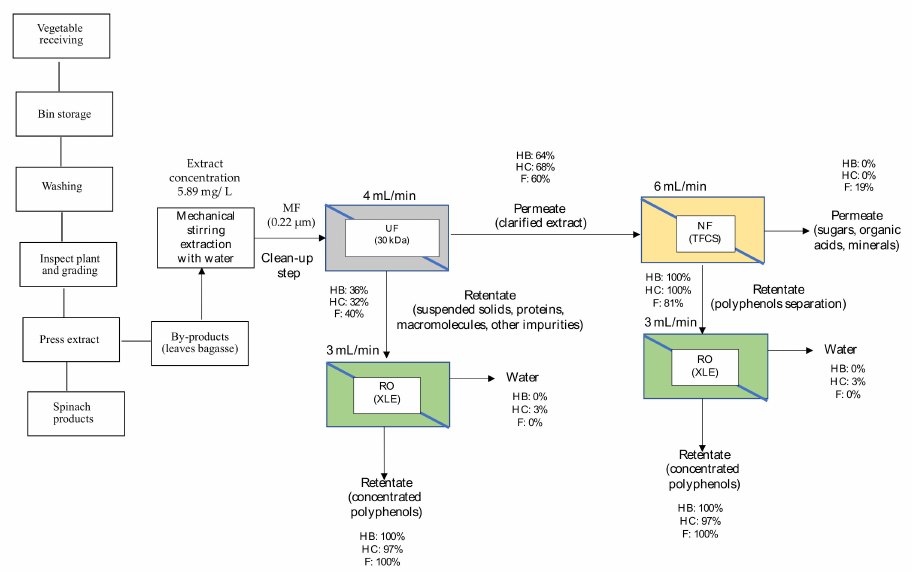
Figure 6. Scheme of the proposed integrated membrane process for the recovery of polyphenols from spinach extracts.